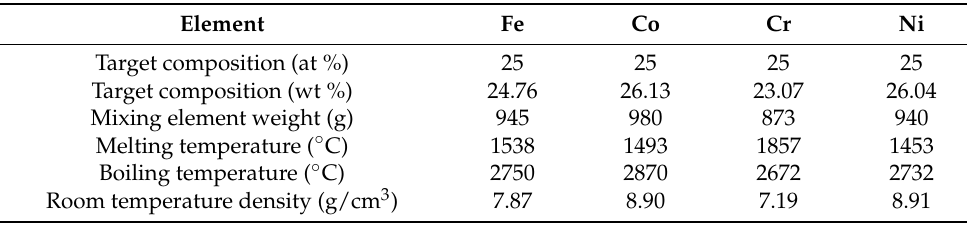
Table 1. Target element composition, actual powder weight, and calculated physical properties of the raw